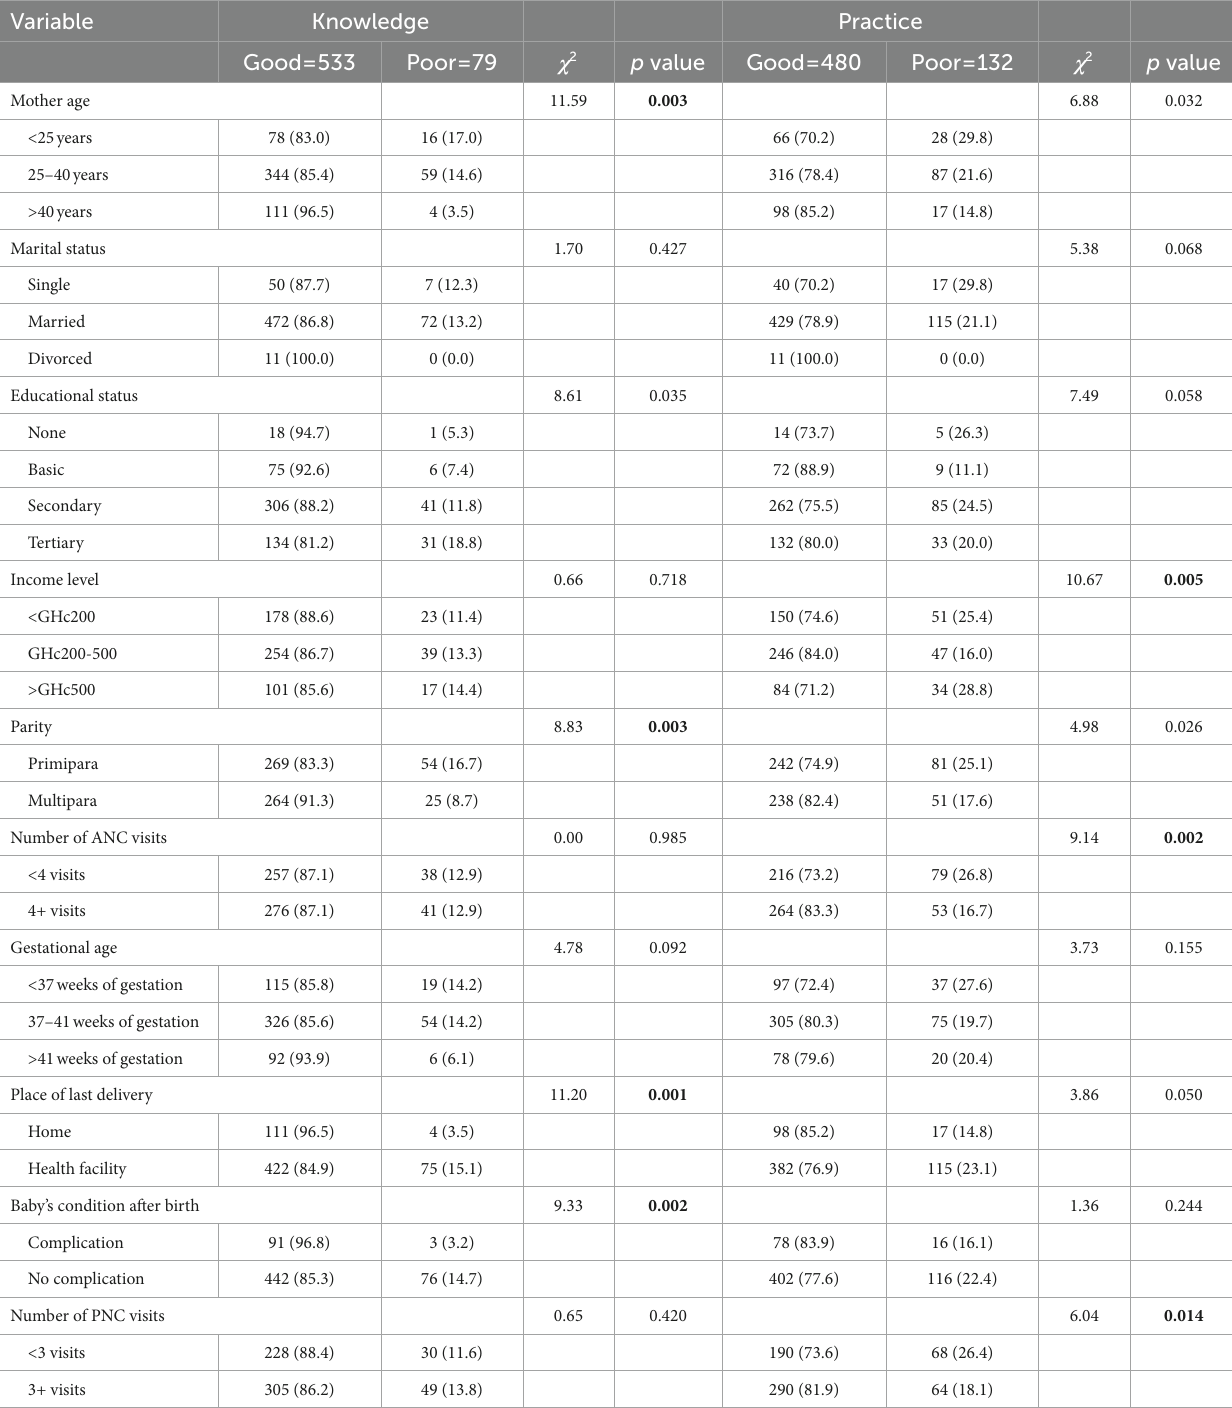
TABLE 4 Association between knowledge and practice of infection prevention in neonates and mothers’ sociodemographic characteristics and reproductive health factors. Variable